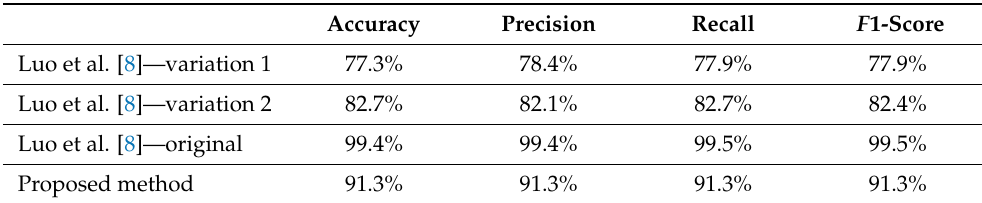
Table 9. Comparison of the classification metrics between our proposed method and that of Luo et al.